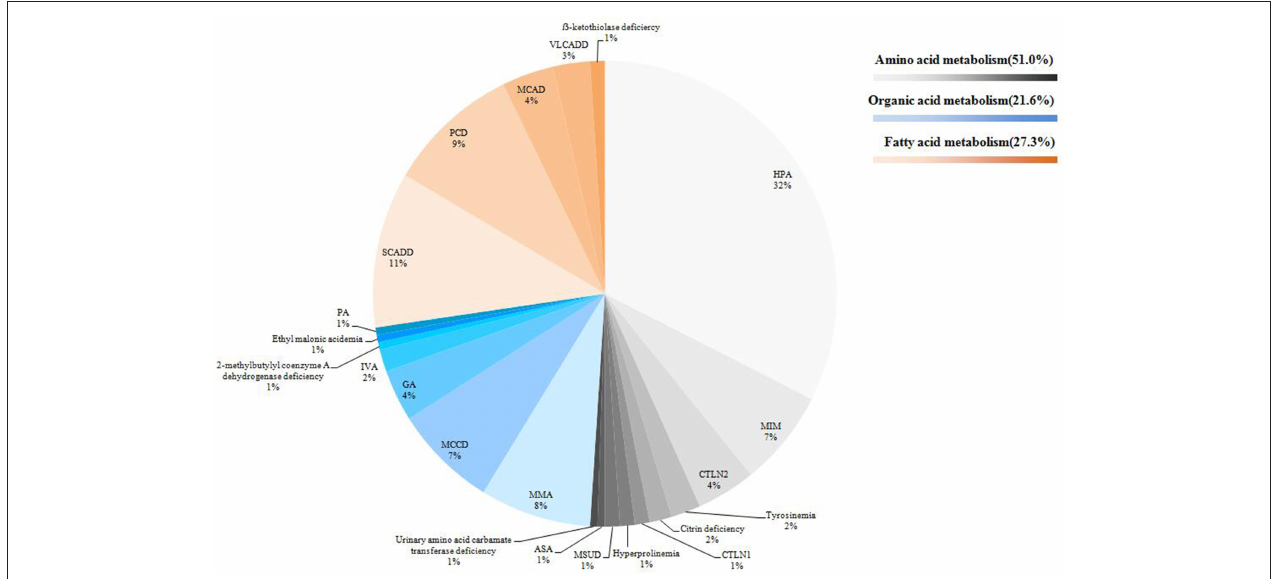
FIGURE 2 | Distribution of all confirmed cases. According to the disease type, 194 cases were displayed by classification and propotion. Among them, amino acid metabolic diseases were expressed in gray system, organic acids in blue system and fatty acids in orange